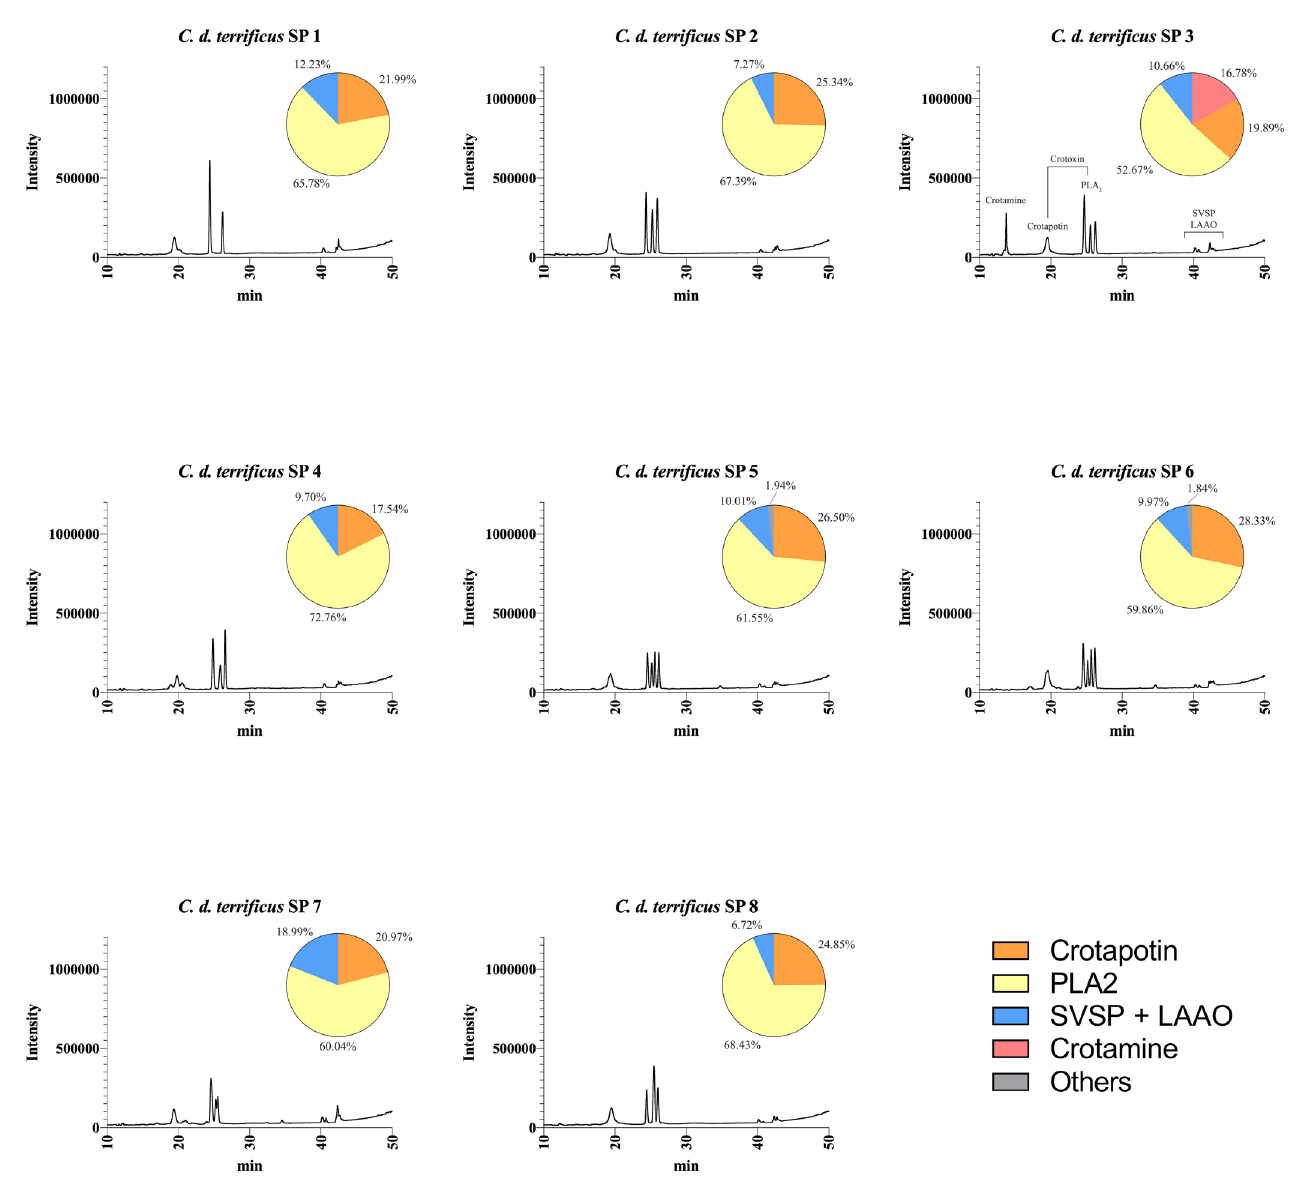
Figure 7. Elution profiles of individual C. d. terrificus venom from São Paulo state by RP-HPLC. Samples of 25 μg of lyophilized venom were dissolved in 0.1% trifluoroacetic acid (TFA) and 5% acetonitrile (solution A) and subjected to RP-HPLC on a C18 column. Elution was performed at 1.0 mL/min by applying a gradient toward 0.1% TFA and 95% acetonitrile (solution B), as described in the experimental section. The main chromatographic peaks of one representative were assigned to its major components. This representative was selected based on the presence/absence and intensity of particular chromatographic peaks. LAAO: L-amino acid oxidases; SVSP: snake venom serine proteases, PLA : phospholipases A . 2 2